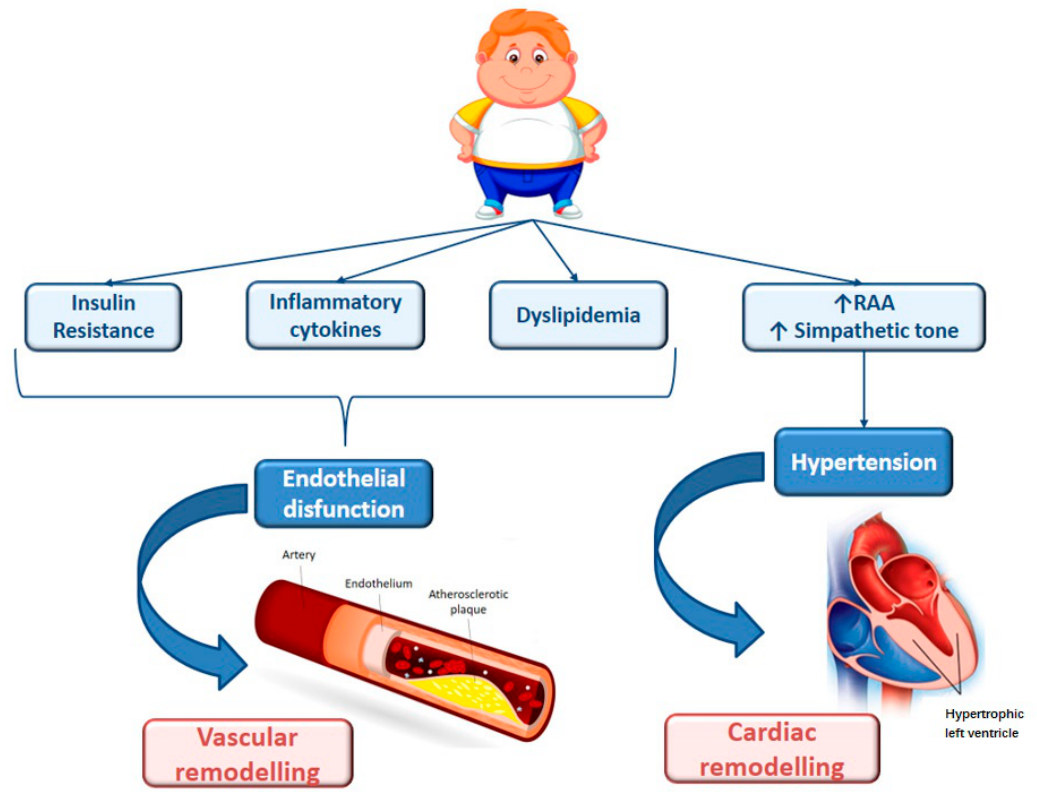
Figure 1. Risk factors for cardiovascular remodelling in obese children. The arrow means that there is an increase in sympathetic tone and in the activity of RAA system .